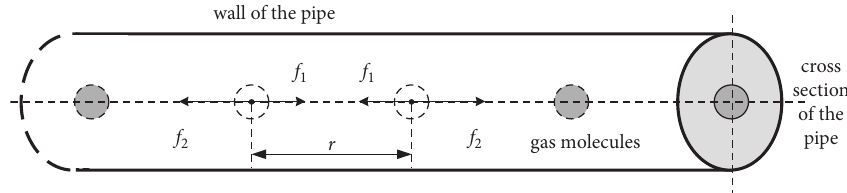
Figure 3: Gas molecules in a long narrow